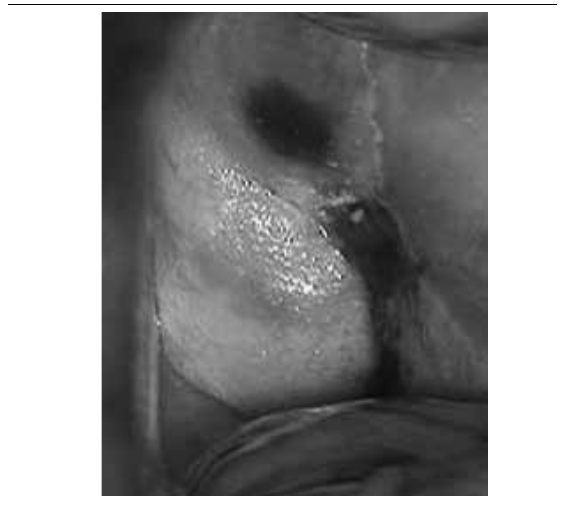
figurE 1 – Colposcopy showing pigmented lesion on the anterior lip of the uterine cervix (16×)